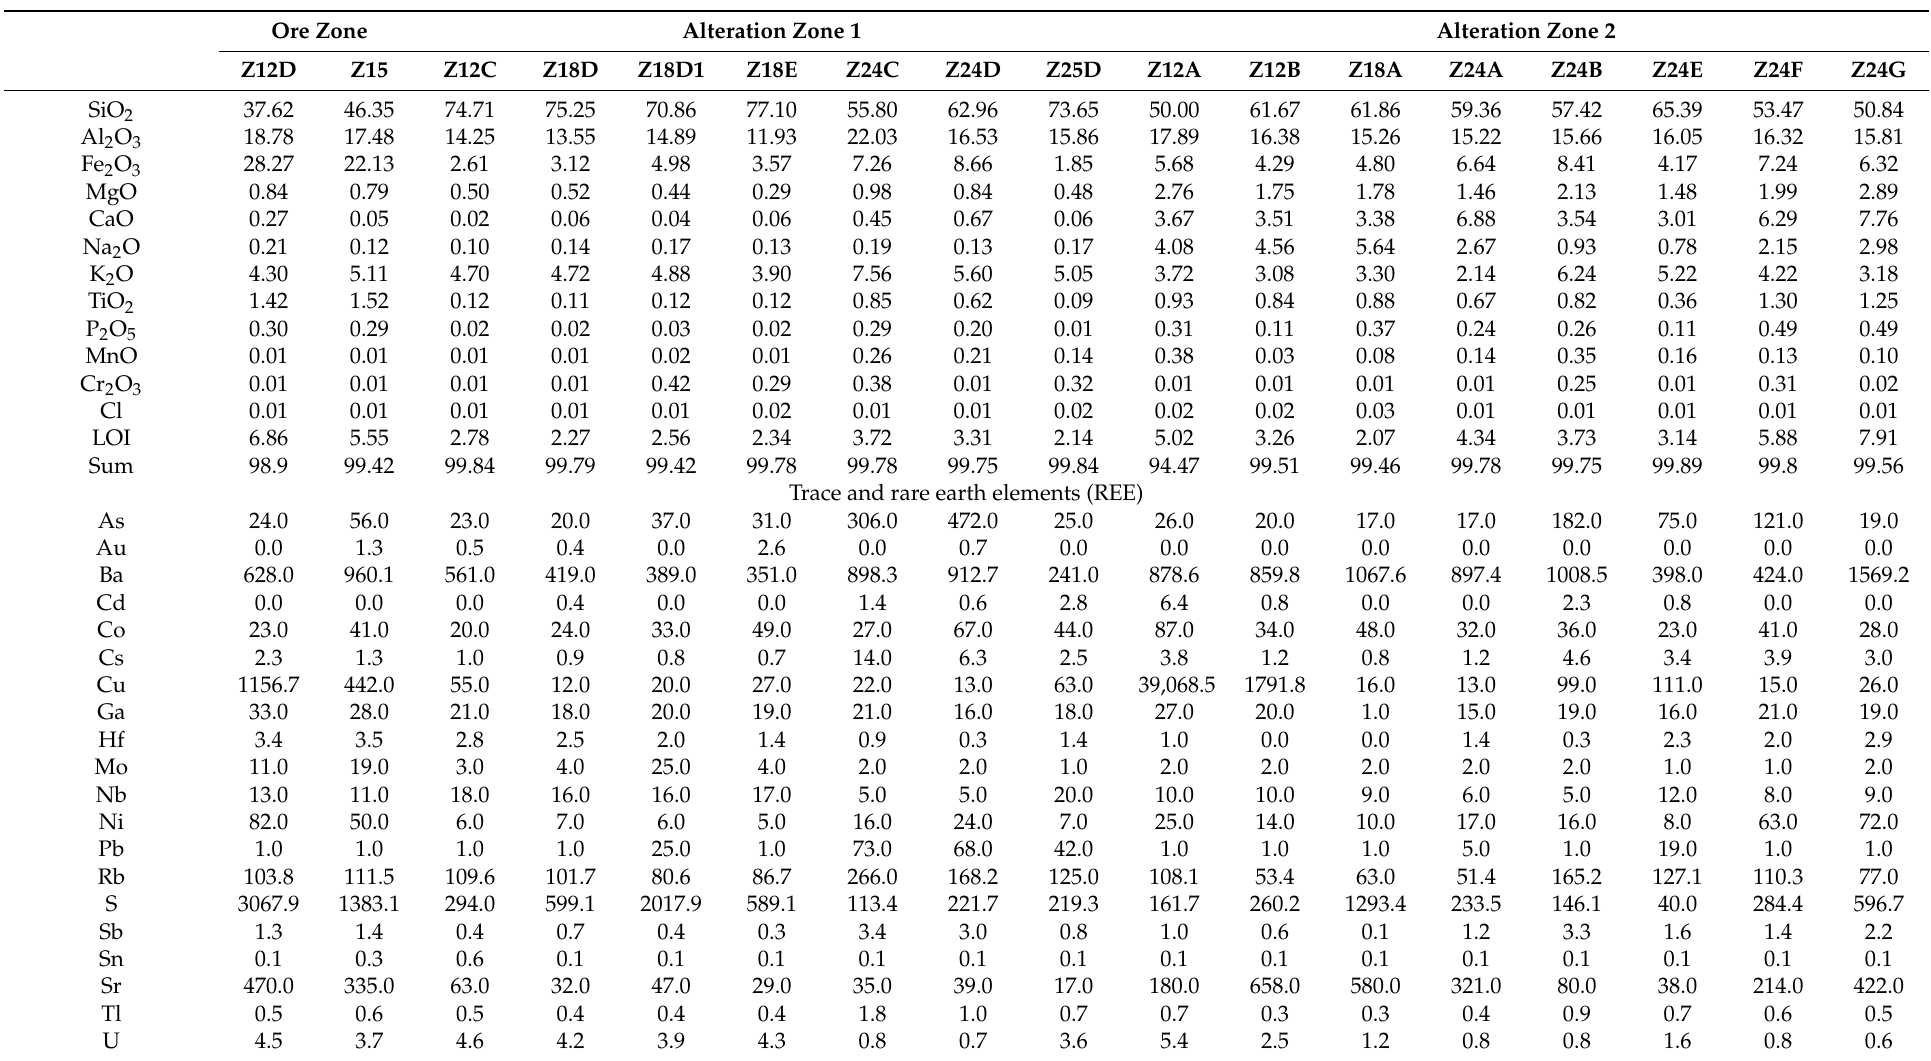
Table 4. Major oxides, trace, and REE of the ore zone and different alteration zones of Abu the Zawal (Fatira)